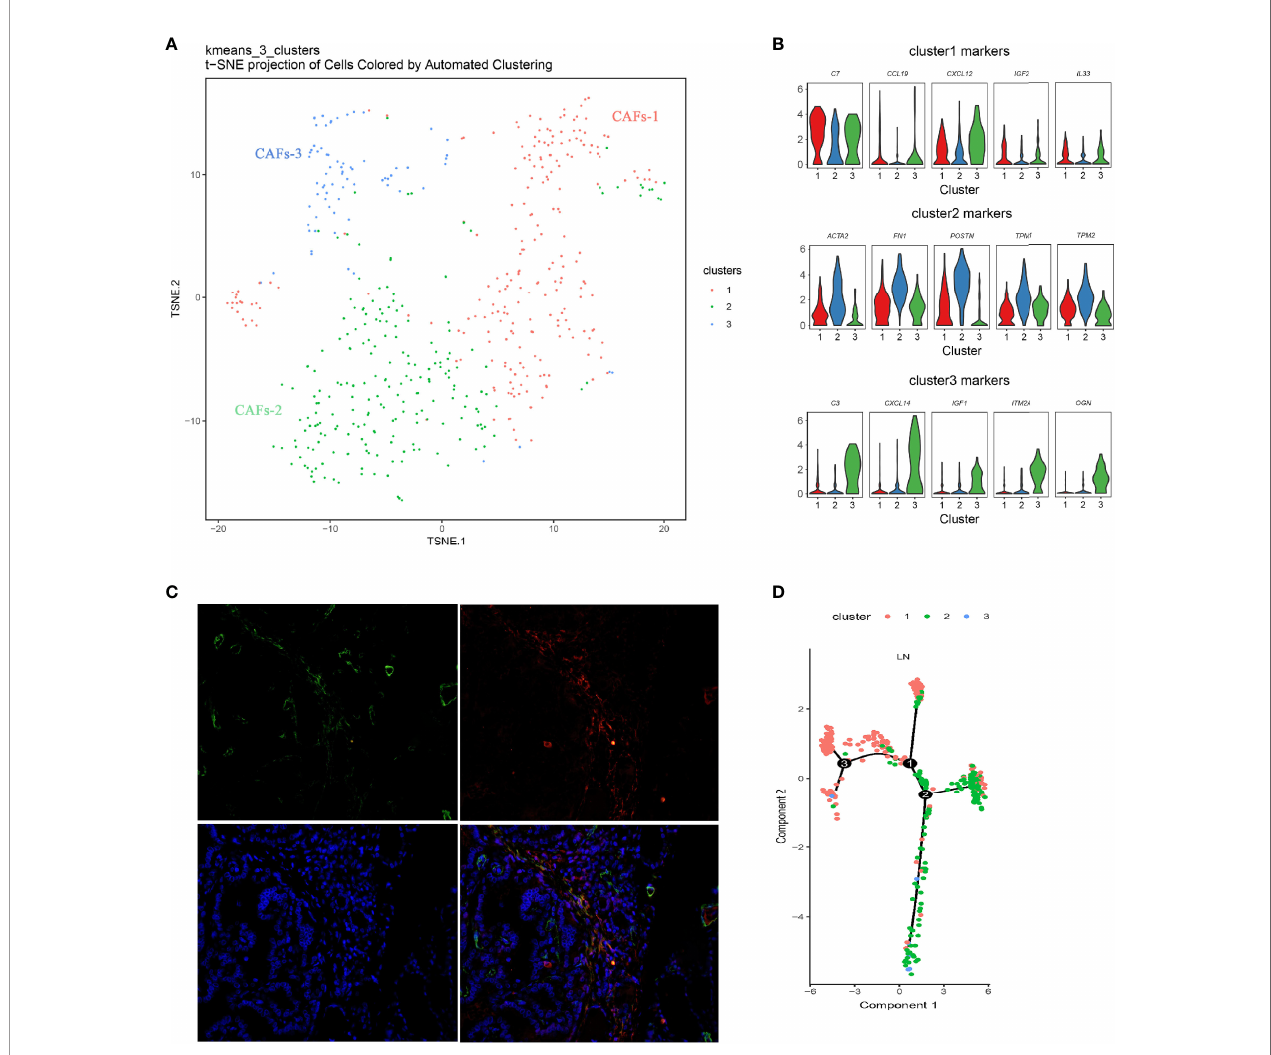
FIGURE 5 | Diversity of CAFs in PTC (A) Reclustering of CAFs represented as a t-SNE plot. (The closer together cells are plotted, the more similar they are; k- means cluster assignment is indicated by color). (B) Violin plots of selected genes, showing normalized expression in the different subclusters. (C) Double immuno fl uorescent staining for ACTA2 and FAP in human metastatic PTC tumors. (D) Pseudotime analysis of CAFs in metastatic PTC. Each point corresponds to a single cell, and each color represents a cell cluster. LN, lymph node metastasis; CAF, Cancer-associated fi